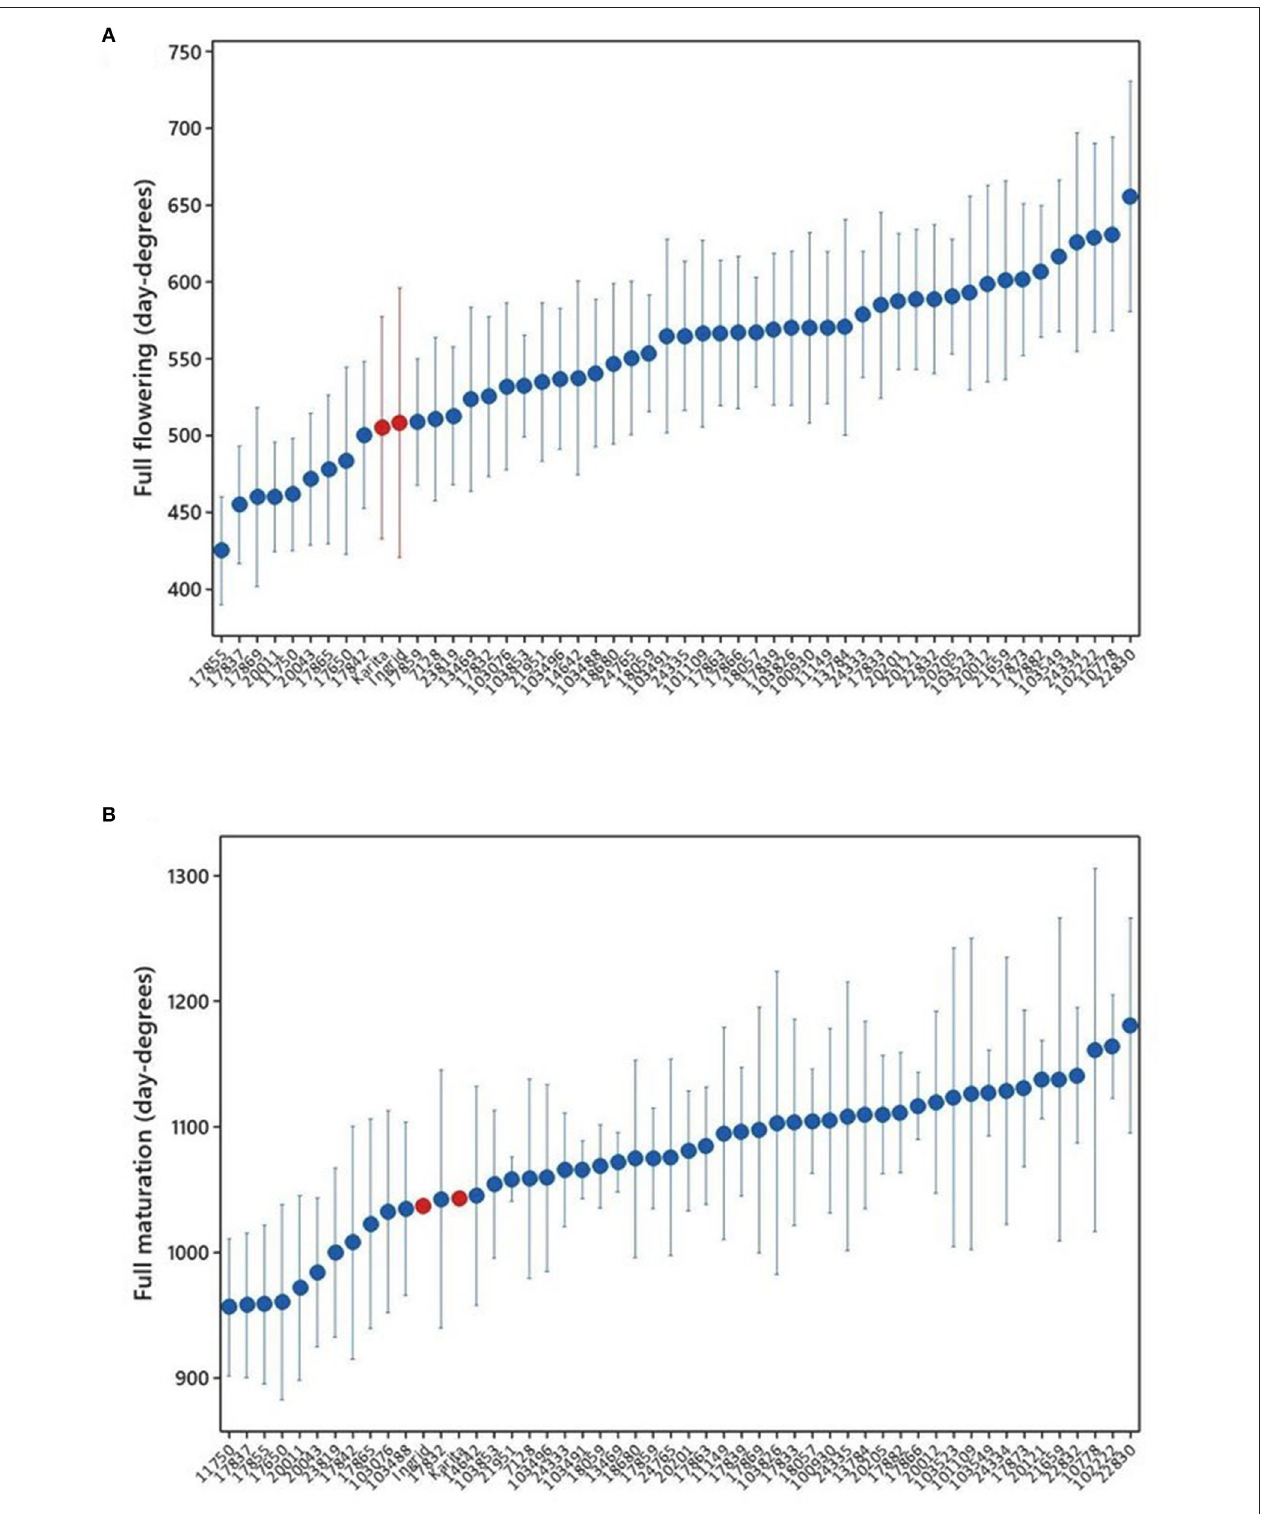
FIGURE 4 | Average day-degree sums for the development of (A) full flowering, sample size n = 7–8 in all accessions, except reference cultivars “Karita” and “Ingrid” (in red color), which were only tested in 2019 ( n = 4), and (B) full maturation of pods in accessions grown at all sites and in both years. The development of fully mature pods was observed at ( n = 4–5) location x years, except for “Karita” and “Ingrid” in 2019, where there were data only from Jokioinen. There was no development of mature pods in Tromsø in either year and in Umeå in 2019. The data for full maturation were not recorded and are therefore missing at Taastrup for the year 2019.